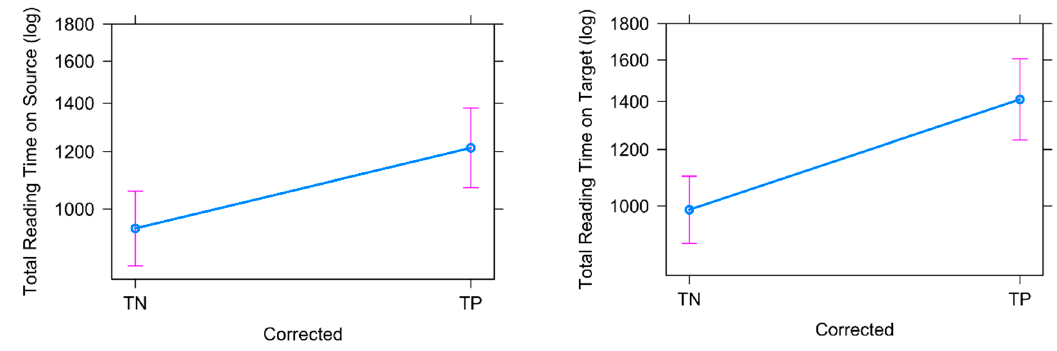
Figure 7. Effect of Corrected on total reading times in ST ( left ) and TT ( right ).